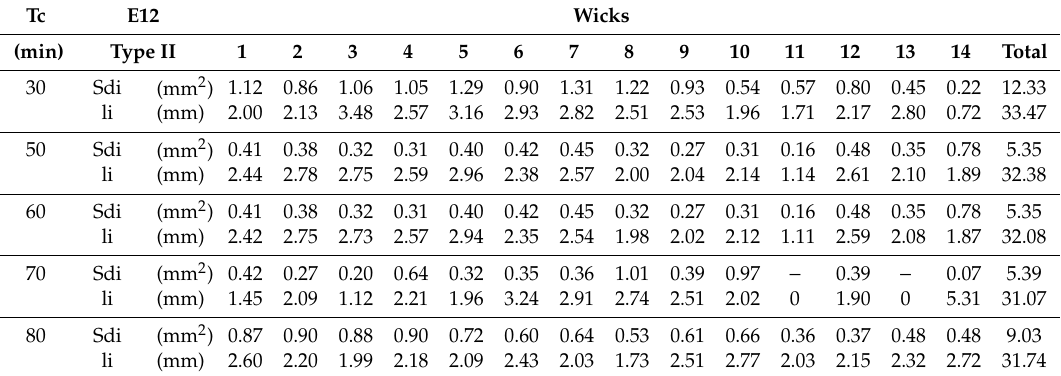
Table 3. Example of Type II delamination data sheets for test 12.